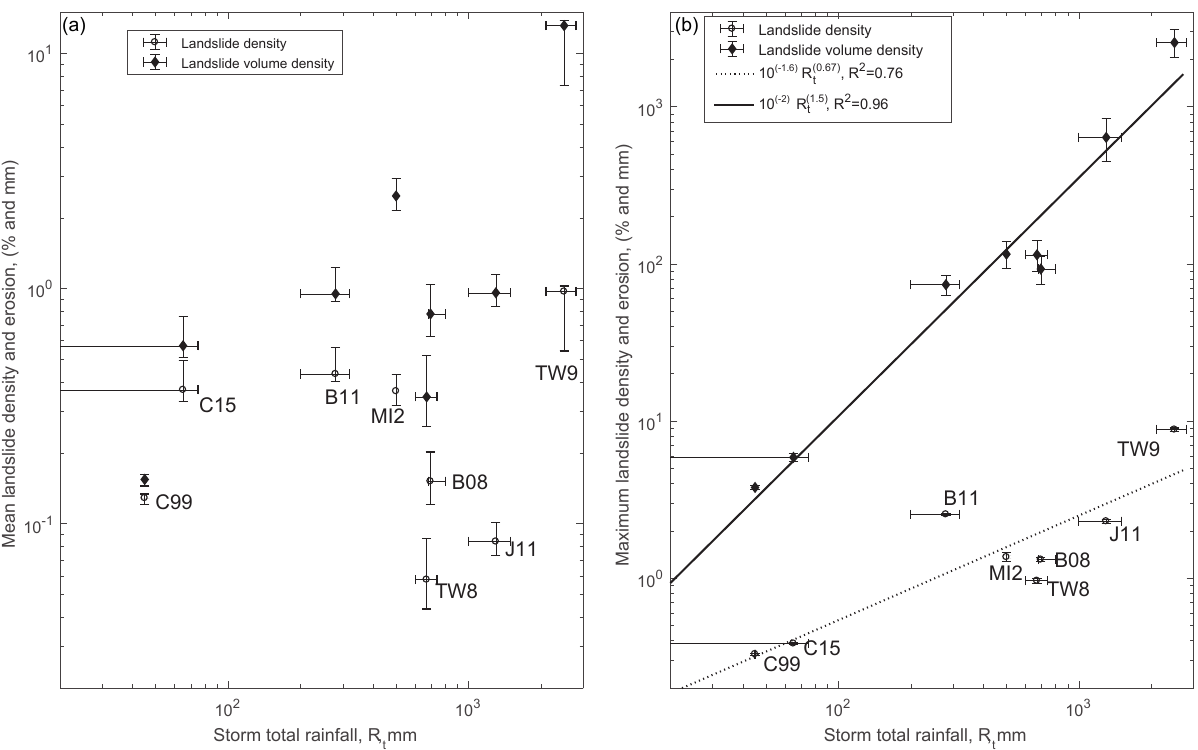
Figure 6. Mean landslide density (a) and peak landslide density in a 0.05 ◦ sliding window (b) , against storm total rainfall. Landslide area and volume are derived from scar estimates, i.e., removing run-out contribution. Horizontal error bars show a range of maximum storm rainfall when available (cf., Table 1). Vertical error bars are based on the range of affected area in (a) (the most uncertain term), and represent 1 σ uncertainty in the total volume and area density in (b) , ignoring potential landslide mis-detections (cf.